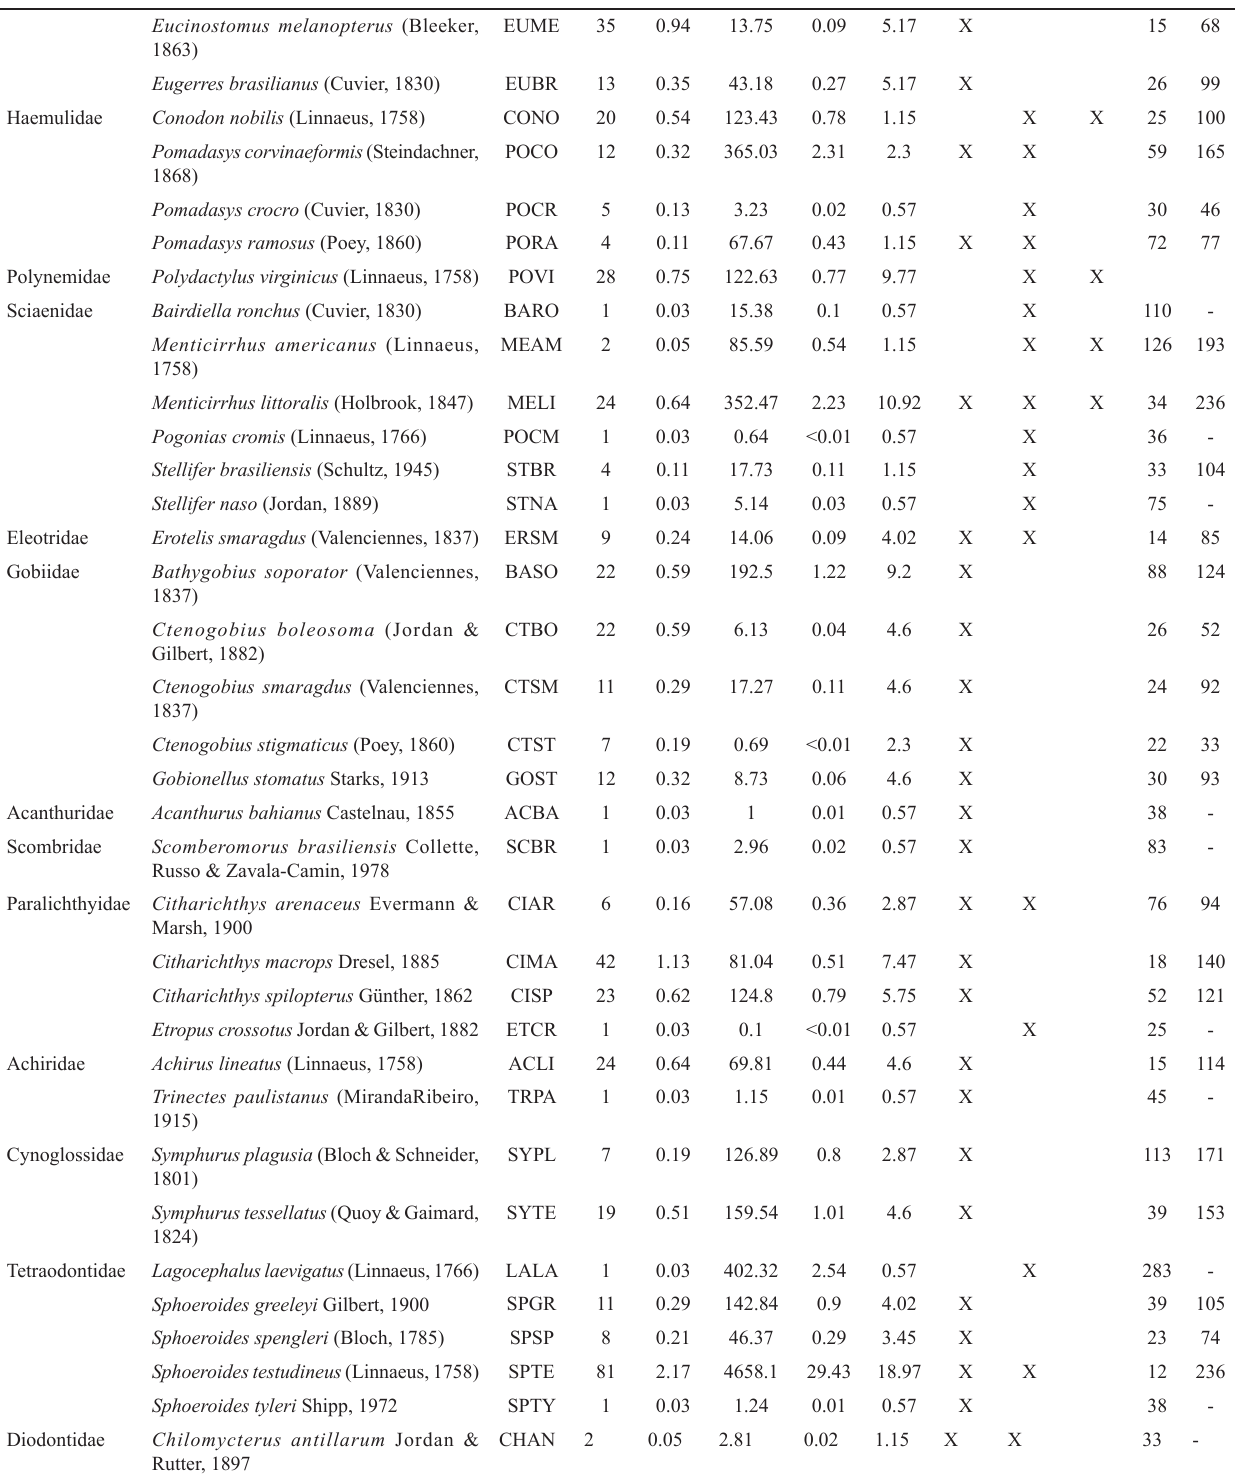
Table 2. Cont. Numerical abundance, biomass, frequency of occurrence, spatial distribution and maximum and minimum length of fish species captured on three beaches in the Mamanguape River estuary of Brazil. The species are ordered in accordance with Nelson